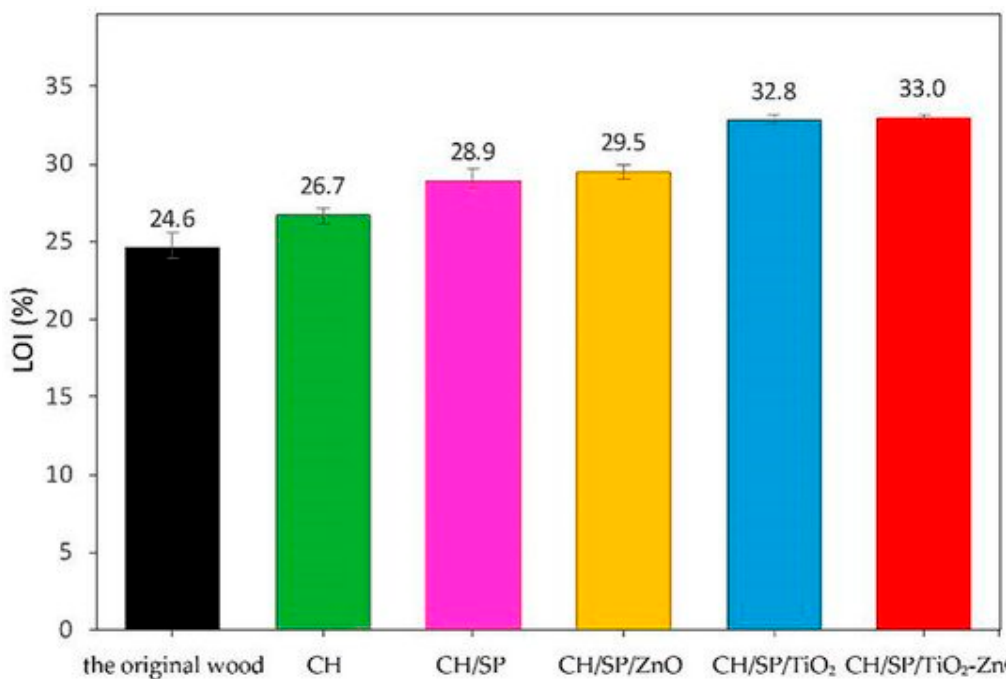
Figure 32. Limiting Oxygen Index values for uncoated and LbL-treated wood. CH: Chitosan-coated (green); CH / SP: chitosan sodium phytate-coated (purple); CH / SP / nano-ZnO: chitosan / sodium phytate / nano-ZnO-coated (yellow); CH / SP / nano-TiO 2 : chitosan / sodium phytate / nano-TiO 2 -coated (blue); CH / SP / nano-TiO 2 -ZnO: chitosan / sodium phytate / nano-TiO 2 -ZnO-coated. Reprinted from [57] under CC BY 4.0 license.